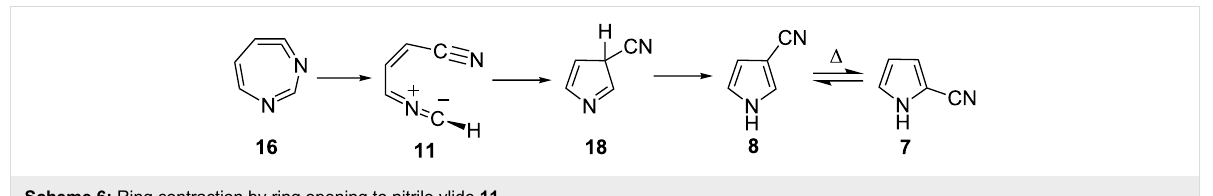
Scheme 6: Ring contraction by ring opening to nitrile ylide 11